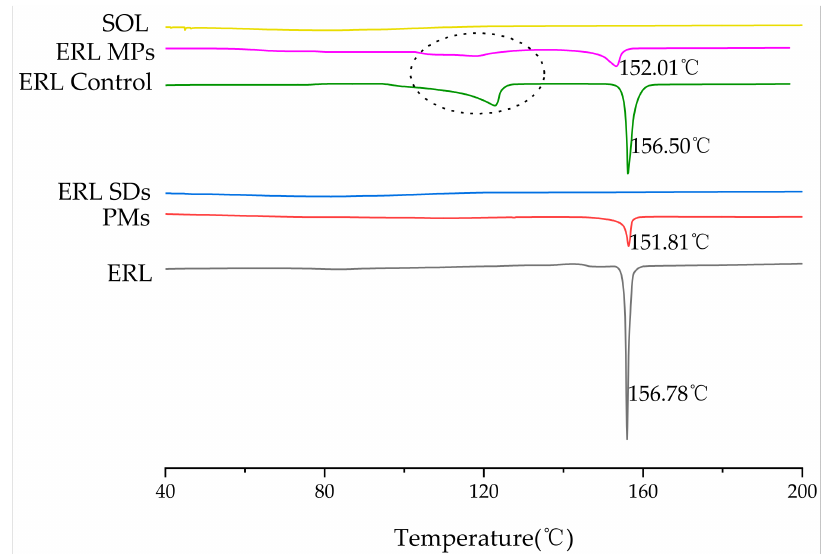
Figure 6. DSC curves of ERL, PMs, ERL SDs, ERL control, ERL MPs and SOL.